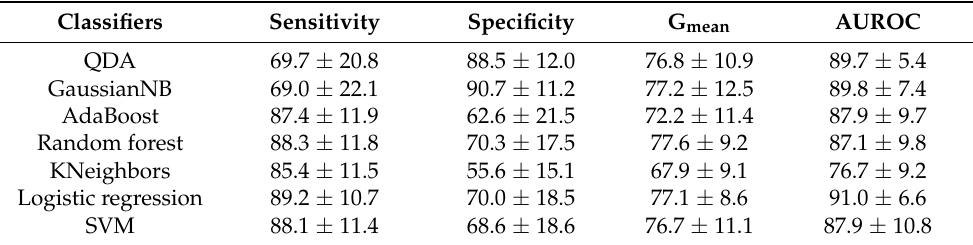
Table 2. Classification metrics ± standard deviation per classifier using EMG feature set.